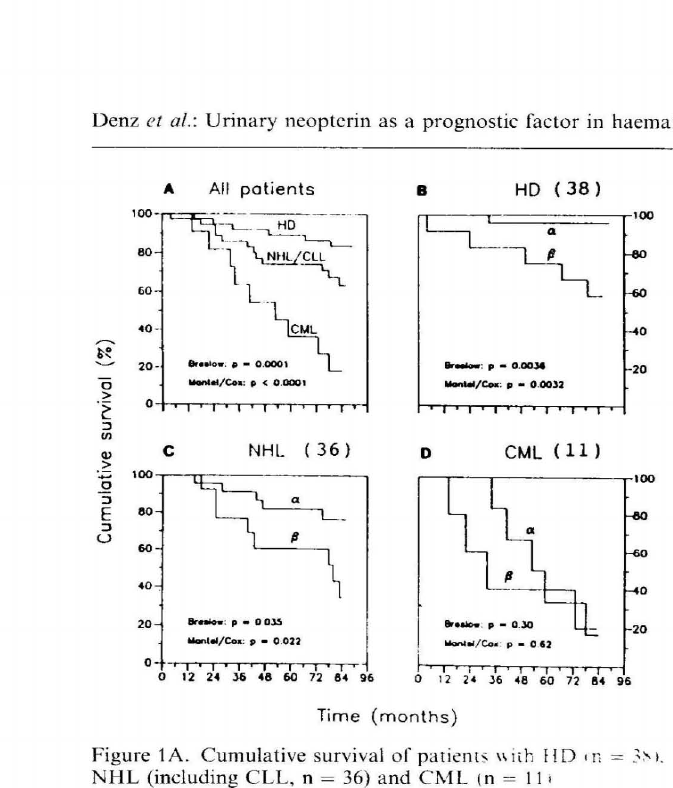
Figure IA. Cumulative survival ofpaticnt5 \\ ilh liD In = 3~1. NHL (including CLL, n = 36) and CML (n = 11 i Figure 1 B. Cumulative survival of patients with H D. a: Patients with neopterin levels < 296 Ilmol mol .::rcalll11ne (n = 26, 68%) ~: Patients with neopterin levels > 296 Ilmolmol nealll11nC (n = 12, 32%) Figure 1 C. Cumulative survival of patients with N H L. a: Patients with neopterin levels < 547 Ilmol/mol creatinine (n = 23, 64%) ~: Patients with ncopterin levels > 547 Ilmol/mol creatinine (n = 13, 36%) Figure I D. Cumulative survival of patients with CML. a: Patients with neopterin levels < 505 Ilmol(mol crcatinine (n = 6) ~: Patients with neopterin levels > 505 Ilmol 'mol creatinine (n = 5) prognosis, more than 80% of patient being alive after 7 years. In NHL patients survival probability was